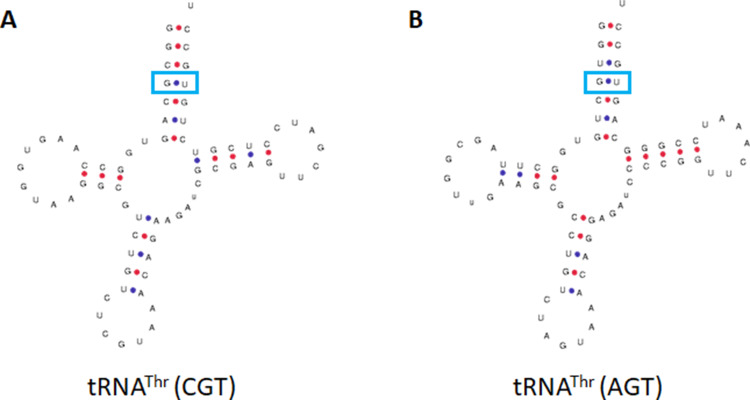
Salpingoeca rosetta tRNAs containing G4•U69.The predicted tRNAs from the S. rosetta genome containing G4•U69 in (A) tRNAHis and (B and C) tRNAGln.